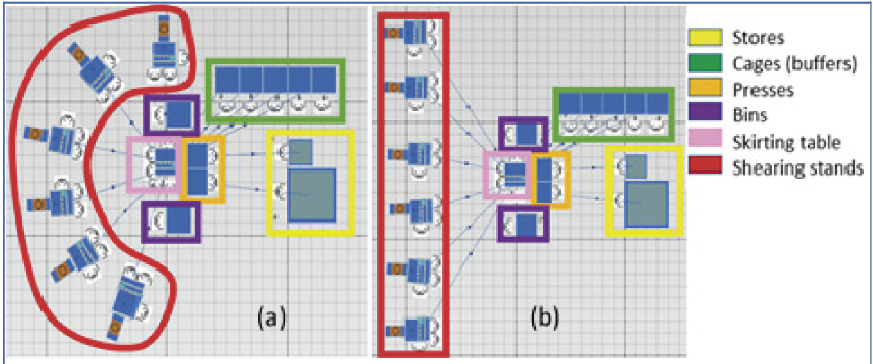
Figure 5. Shed layout in Plant Simulation, (a) Curved, (b) Linear shearing stand arrangement, blue arrows represent fleece movements